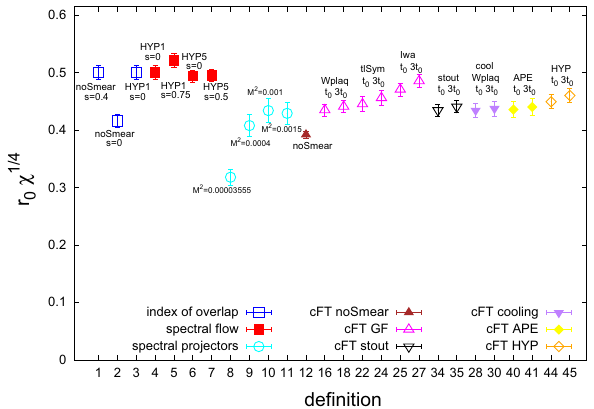
Fig. 12 Topological susceptibility for ensemble b40.16 (with pion mass around 340 MeV), using representatives of different kinds of